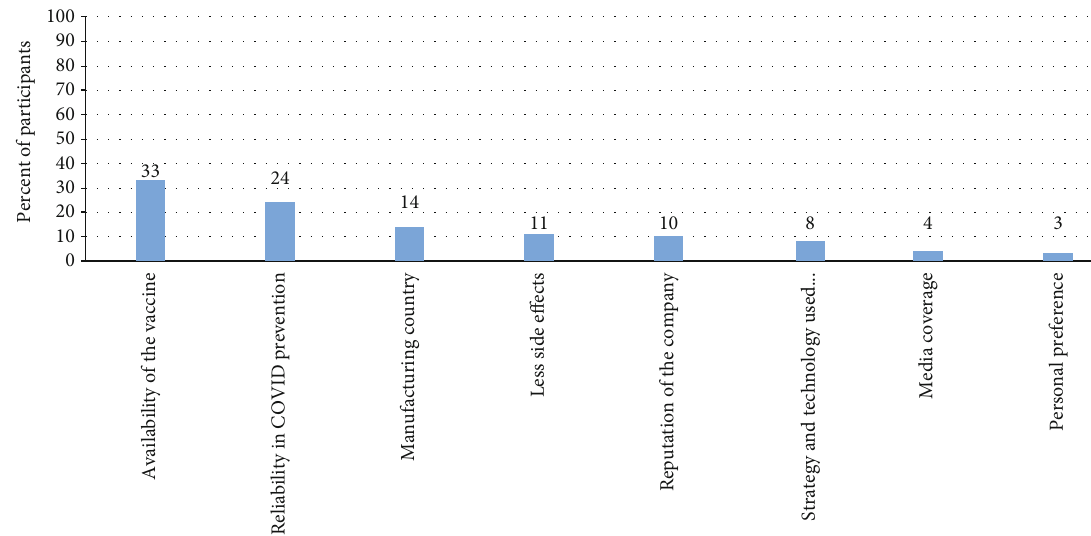
Figure 5: Factors a ff ecting the choice of COVID-19 vaccines as reported by the